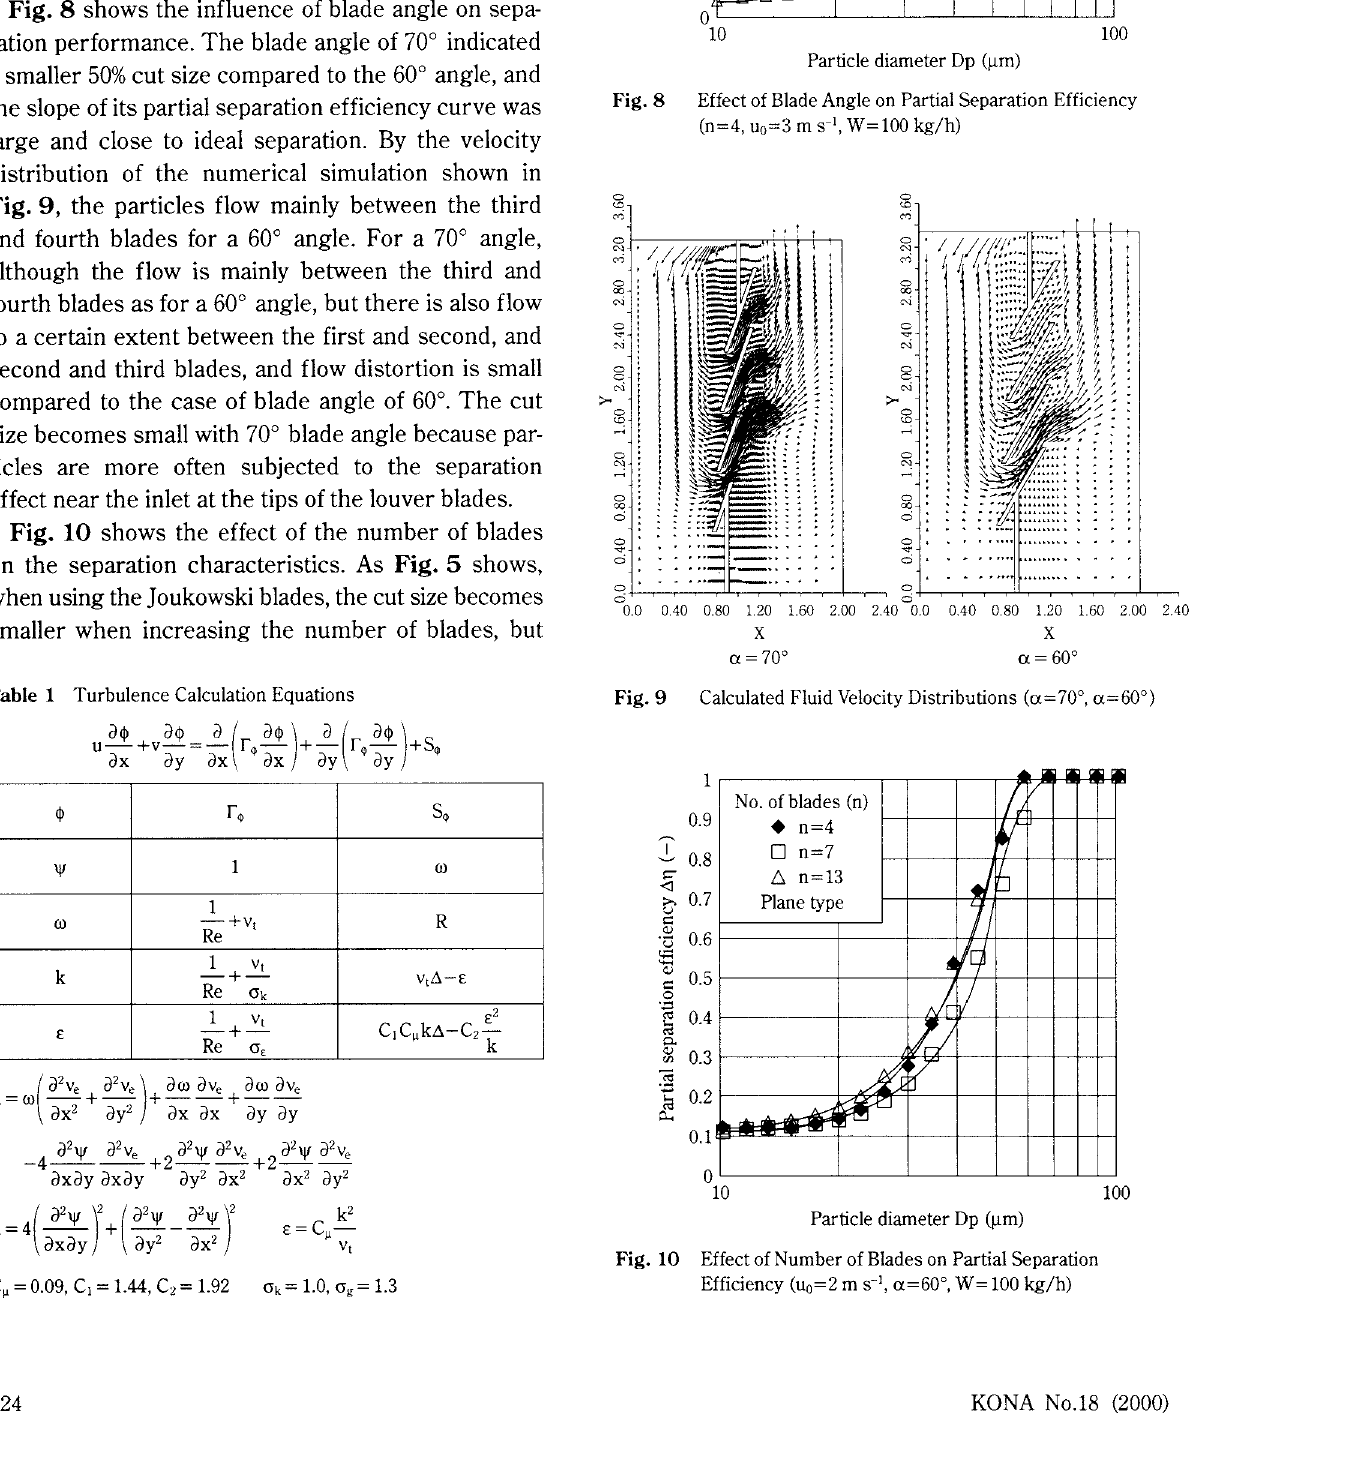
Effect of Blade Angle on Partial Separation Efficiency